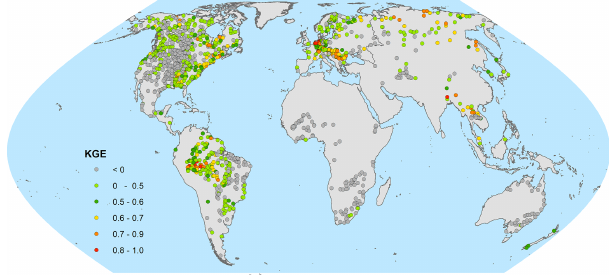
Figure 3. Global map of Kling–Gupta efficiency based on 1366 GRDC